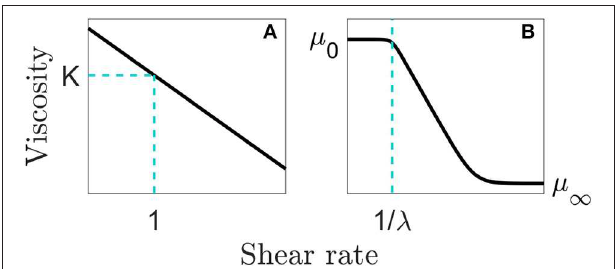
FIGURE 1 | Sketch of two shear thinning rheologies: (A) pure power-law model with two parameters K and n , (B) Carreau model with five parameters µ 0 , µ , λ , n and α ∞